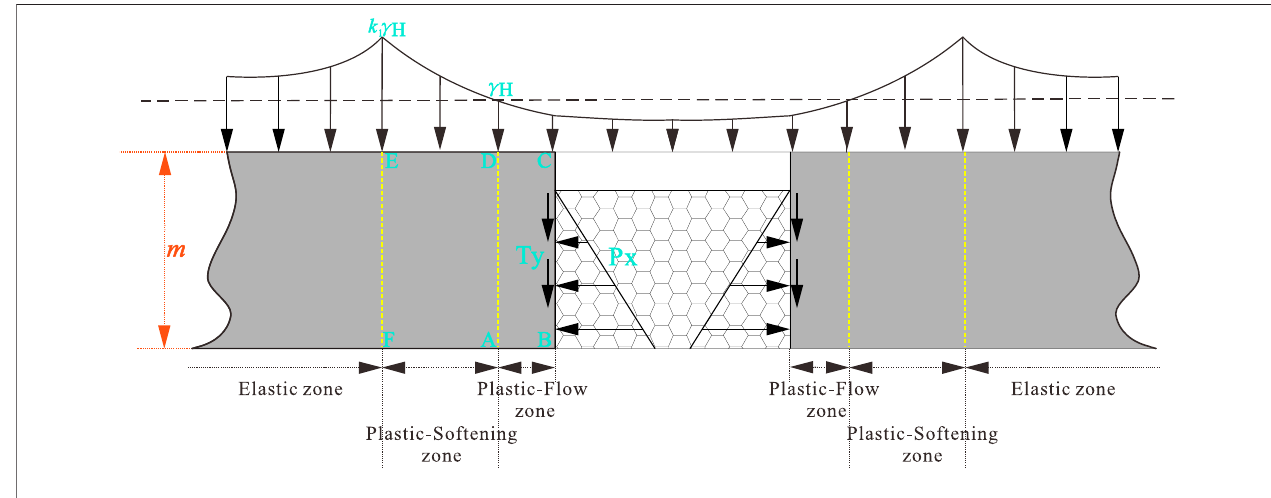
FIGURE 2 | Schematic diagram of the mechanical model without roof connection (single-side gob